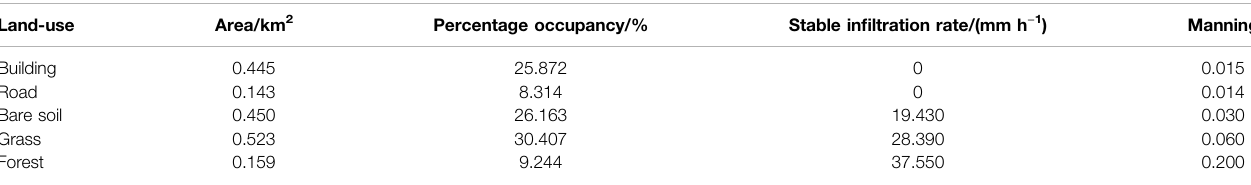
TABLE 1 | Properties of the underlying surface and manning coef fi cients. Land-use